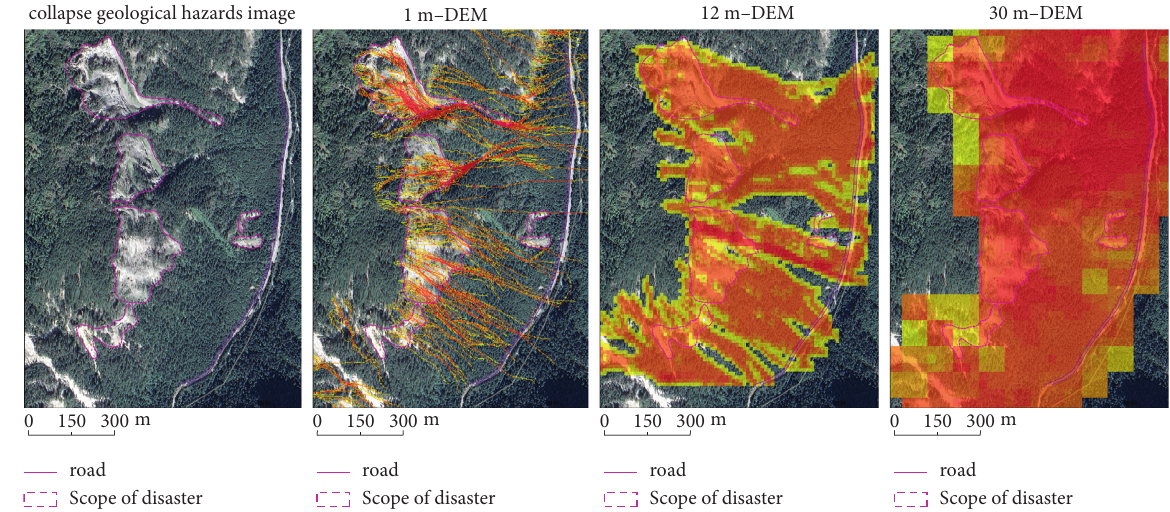
Figure 8: DEMs with different resolutions have different results in disaster evaluation along highways.